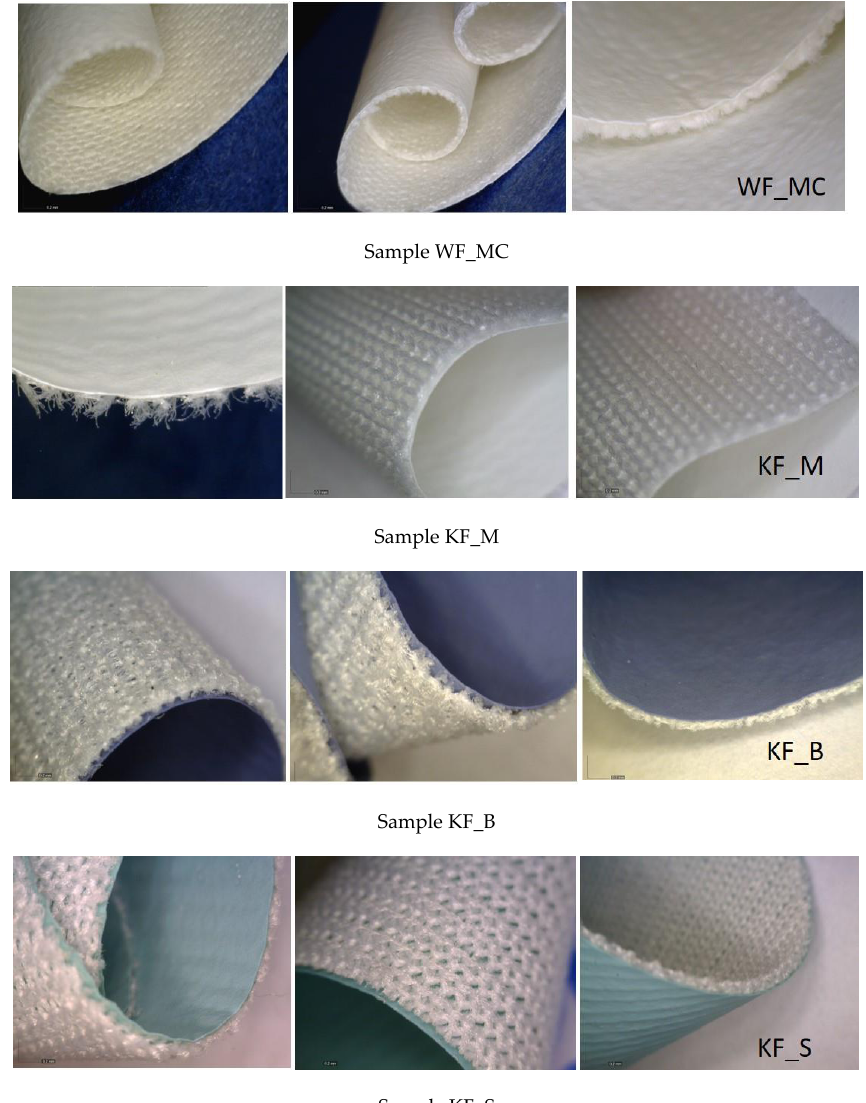
Figure 1. Polyurethane (PU) laminate surface .